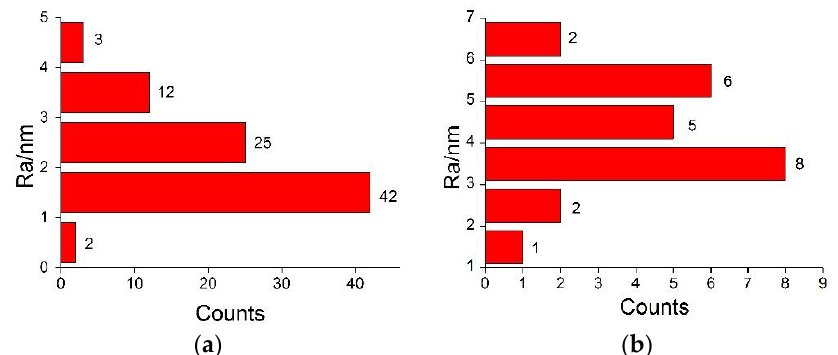
Figure 4. Roughness distribution. ( a ) correlation length 0.23 μm; and ( b ) correlation length 1 μm.